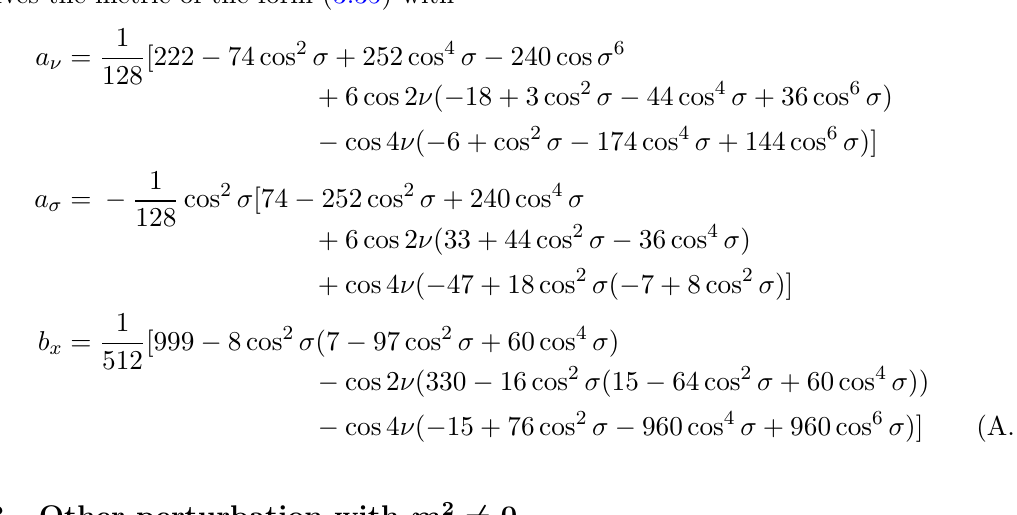
Figure 7 . Penrose diagrams of the perturbed BTZ black hole. (a) m = 0 with the perturba- p tion (A.1) (b) m = 3 =‘ with the perturbation (B.1). gives the metric of the form (3.35)